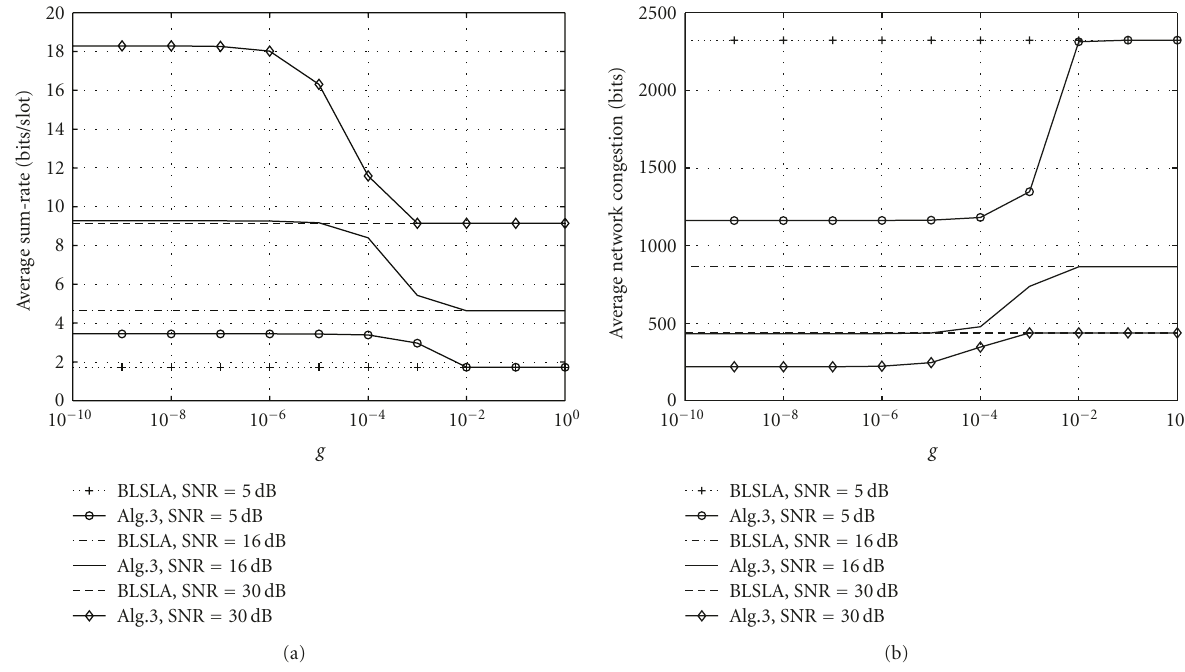
(cid:2) 2 (a) and of the average network congestion x s s s = 1